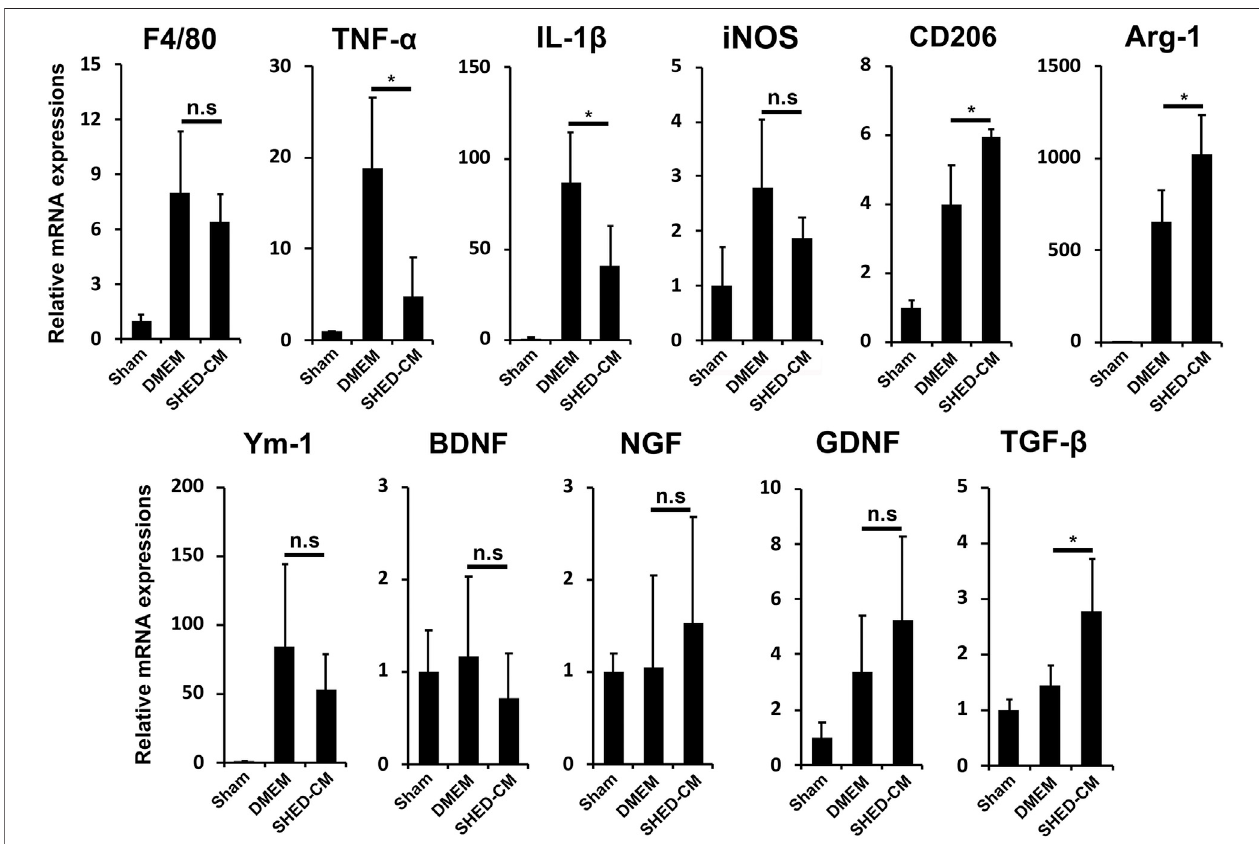
FIGURE 2 | SHED-CM treatment converts proin fl ammatory microenvironment to an anti-in fl ammatory and tissue-protective microenvironment. qPCR analysis of the indicated mRNAs in the sciatic nerves 3 days after PSL in the early phase model. Student ’ s t -test ( n = 4). Data represent the mean ± SD. * p < 0.05.